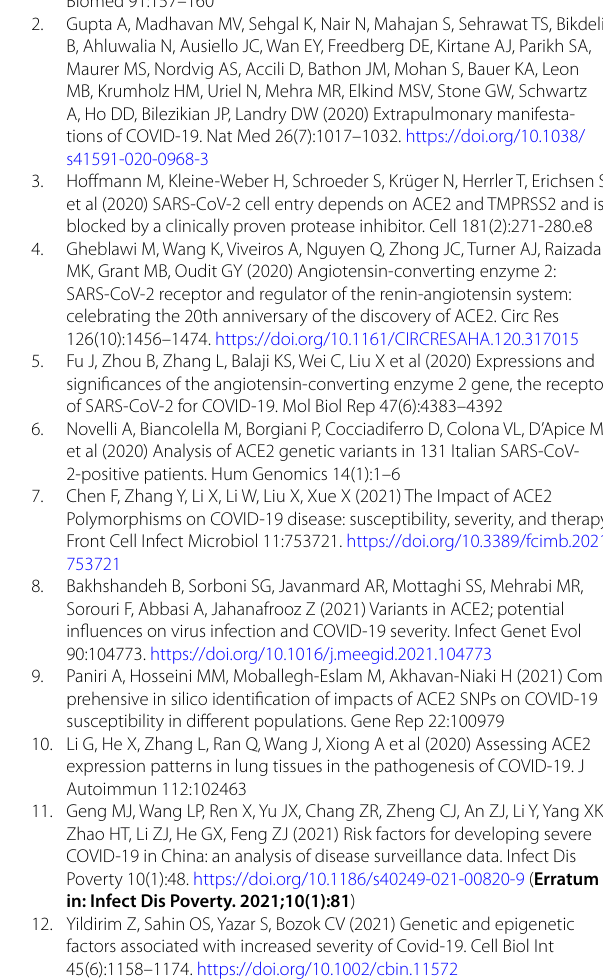
Additional file 2 . Table S1: Laboratory data among studied patients’ groups. Table S2a: Univariate logistic regression analysis for predictors of disease severity. Table S2b: Multivariate logistic regression analysis (Backward: Wald) for predictors of classification. Acknowledgements Not